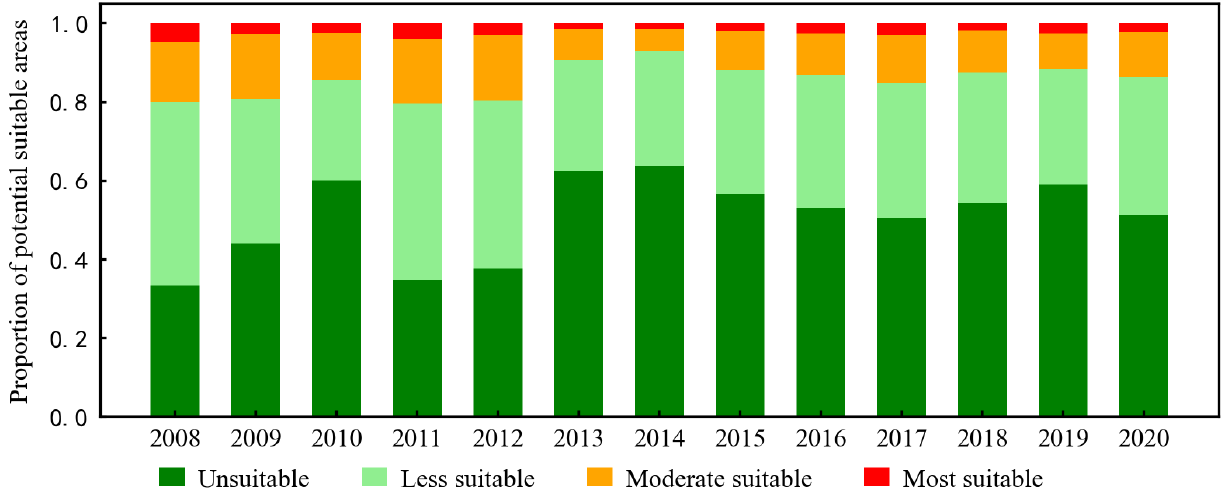
Figure 6. Proportions of area with different levels of suitability for grasshoppers.